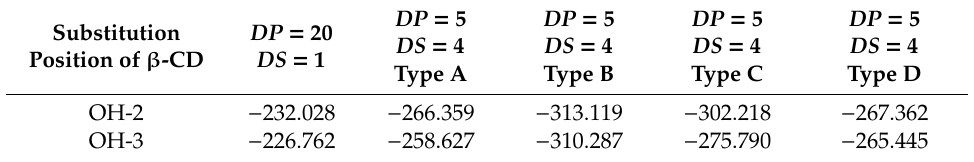
Table 2. Energies (kcal / mol) of the isomers (C 162 H 270 O 75 ) of β -CD / PCL di ff ering in the DP , DS , and β -CD-substituted position (OH-2 or OH-3): Types (A, B, C, D) are explained in Figure 8.